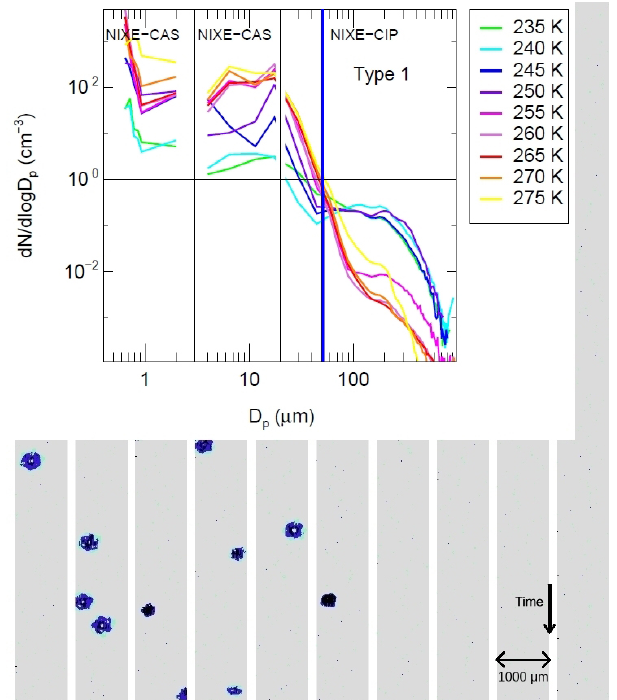
Figure 7. Type 1 clouds: example of CIP images (background pic- ture). The stripes represent a series of CIP shadow images, depict- ing the particles that have passed subsequently through the detector. Foreground: average particle size distributions (PSDs) in 5K inter- vals, all campaigns. The thin vertical line at 3µm marks the bound- ary between aerosol and cloud particles. The line at 20µm marks the transition from the NIXE–CAS–DPOL to the NIXE–CIPg in- strument. The thick blue line divides the cloud particle population into particles smaller and larger than 50µm.